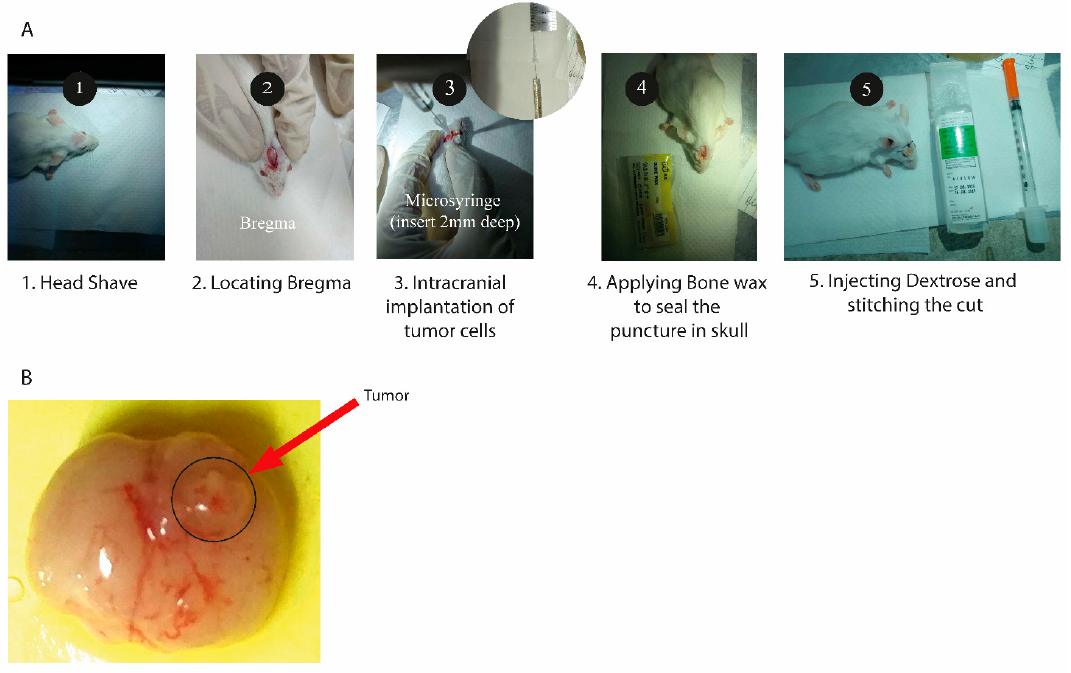
Figure 2. ( A ) Steps for the development of glioblastoma multiforme mouse model. ( B ) Mouse brain with a tumor developed in the right cerebrum (dorsal view).